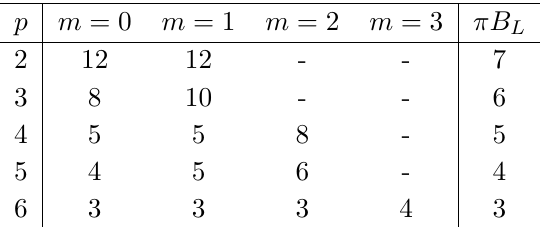
Table 1 . This table lists all the action growth rate at late time for general p and m . They are in unit of the constant c p de(cid:12)ned in eq. (5.10). The last column is showing the Lloyd bound B L also in unit of c p